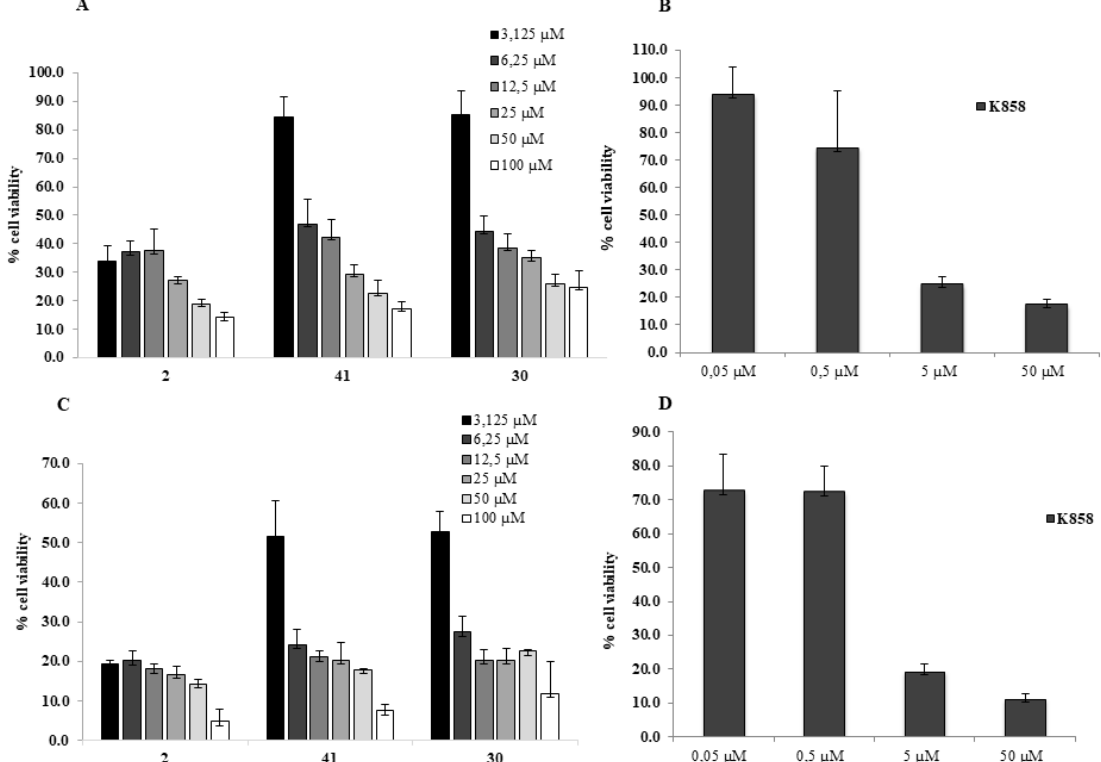
Figure 3. MTT cell viability assay on AGS. ( A , C ) Histograms represent the viability dose-response of AGS cells exposed to di ff erent concentrations of 2 , 41 , 30 (from 3.125 to 100 µ M) for 24 and 48 h. ( B , D ) Histograms represent the viability dose-response of AGS cells exposed to di ff erent concentrations of K858 (from 0.05 to 50 µ M) for 24 and 48 h. Proliferation was assessed using MTT assay and normalized to control cells treated with DMSO (0.2% as final concentration). Compounds 2 and 30 differ from the K858 structure only by slight differences on the C5